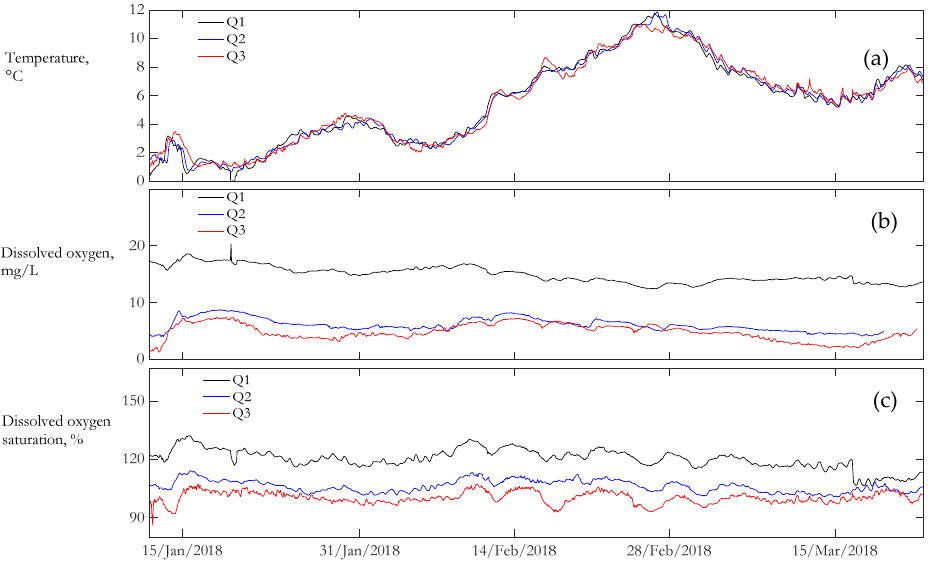
Figure 7. Sensor measurements of ( a ) temperature, ( b ) dissolved oxygen and ( c ) dissolved oxygen saturation at three locations (Q1, Q2 and Q3) of the Kanawha River.